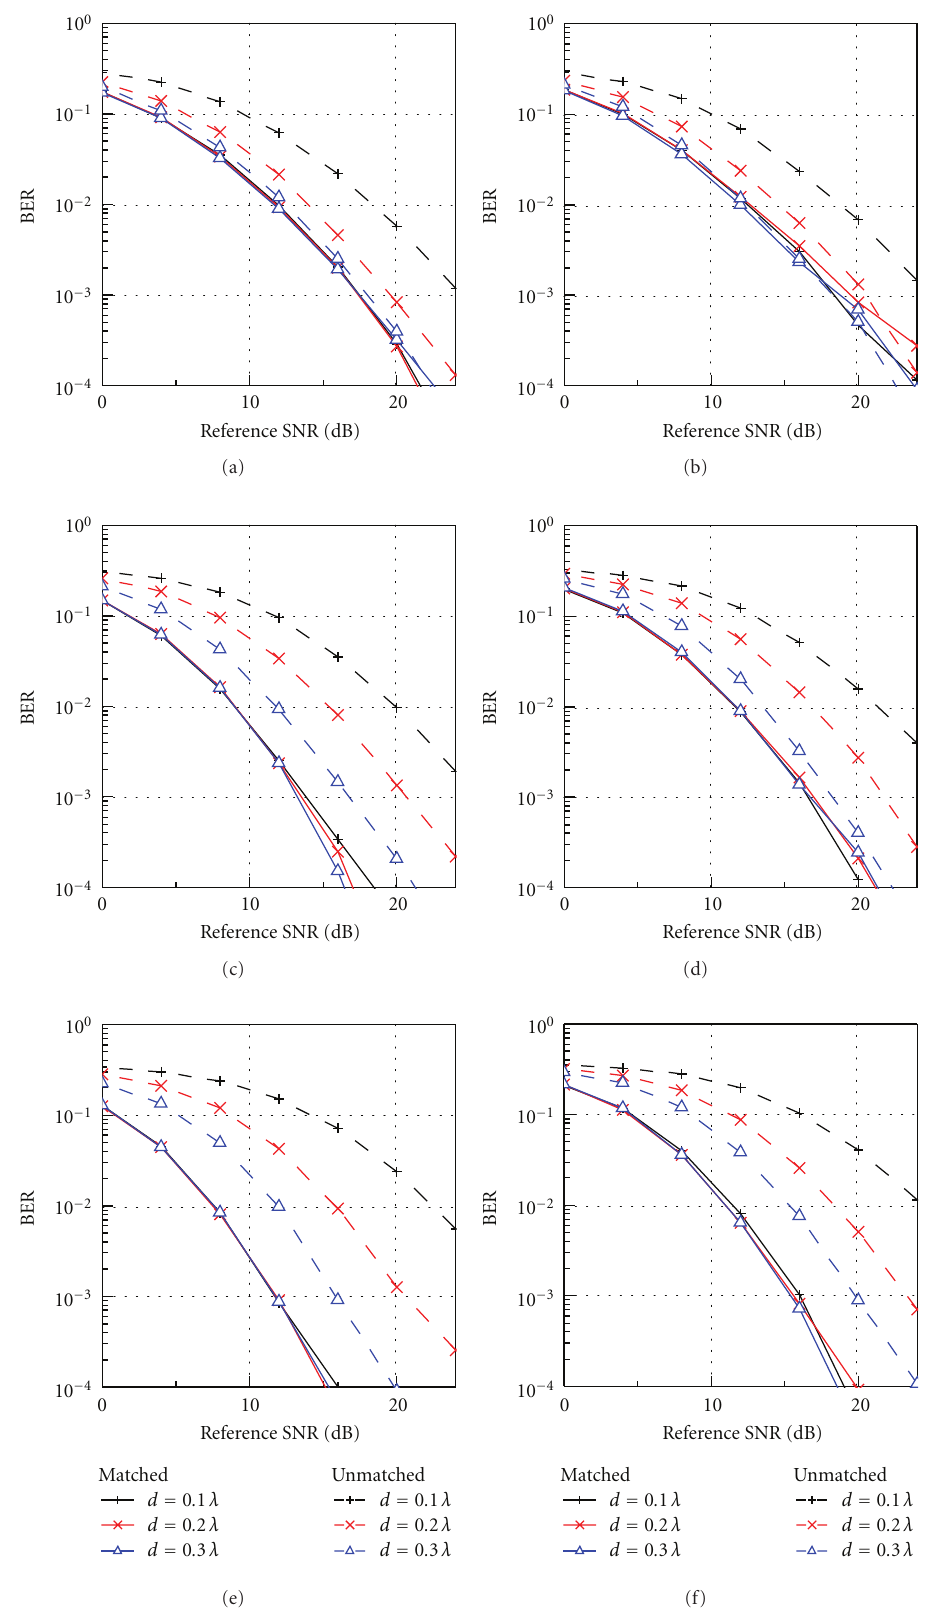
Figure 3: BER performances of the SM MIMO systems with linear arrays in Rayleigh and Rician scenarios: (a) n t /n r = 2, K = 0; (b) /n K = 10; (c) n n t r = 2,